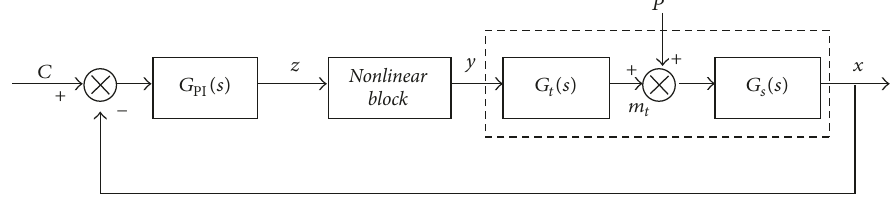
Figure 1: Structure of the hydroturbine governing